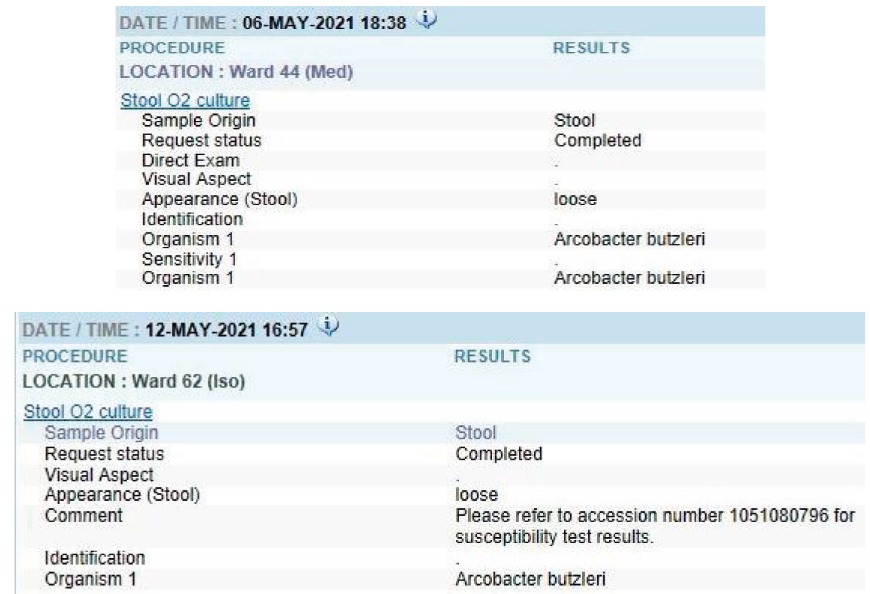
Figure 1: Stool culture reports indicating presence of A. butzleri.